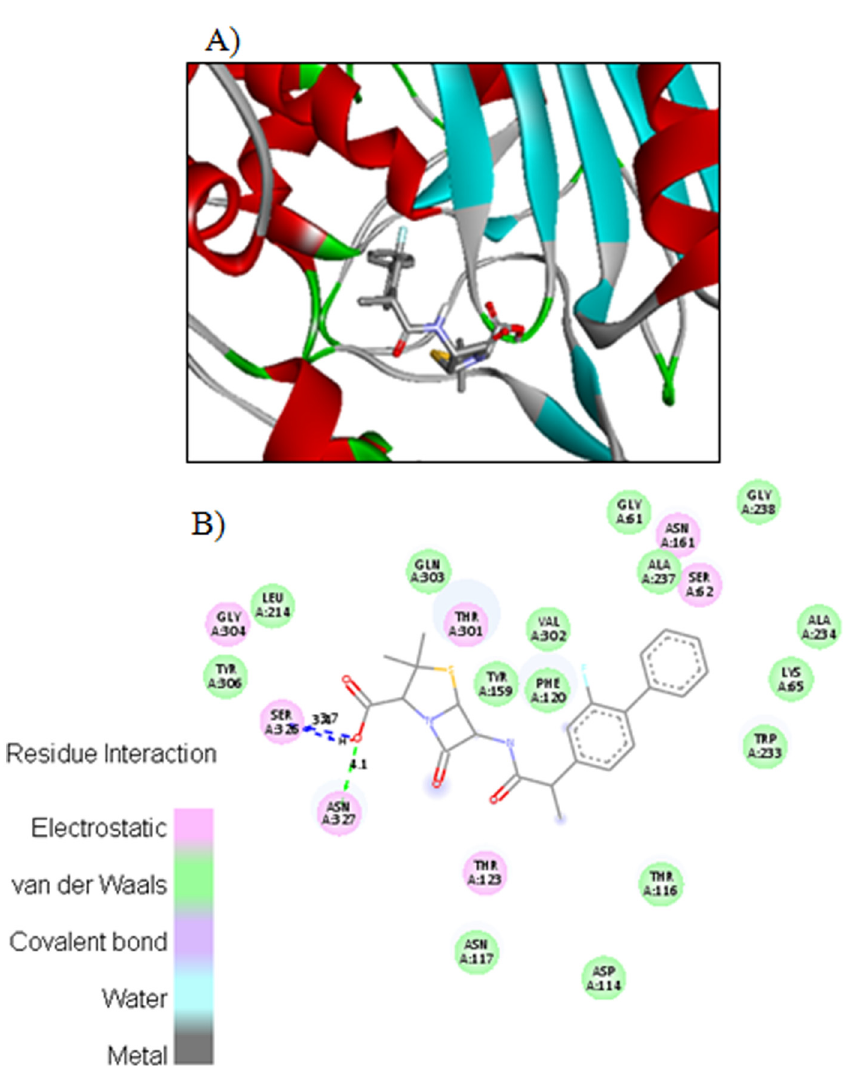
Fig 3. The potential ligand-protein interactions of compound 4c with the active site of Penicillin binding protein (PDB ID 1CEF) generated by using Discovery Studio 4.0. A) The three-dimensional docking of the compound 4c in the binding pocket. B) The two dimensional interactions of 4c with amino acid residues are shown as balls colored by the type of